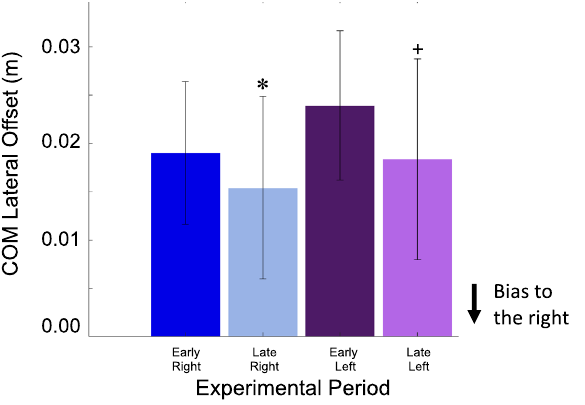
Figure 6. COM Lateral Offset Statistical Results Results of statistical analysis for COM lateral offset. Mean ± SD for COM lateral offset across experimental period. X-axis labels: ER, EL, LR, and LL represent periods early right, early left, late right, and late left respectively. Significance ( p < 0.05) from early field right is denoted by ( ✽ ) and significance ( p < 0.05) from early field left is denoted by ( +). Outcomes from the two-by-two ANOVA found a significant main effect of experimental period ( p = 0.014), indicating that the magnitude of the COM lateral offset was greater during the late field trials than the early field trials. We also found a significant main effect of direction ( p = 0.032), indicating that force field right trials were more biased towards the right than force field left